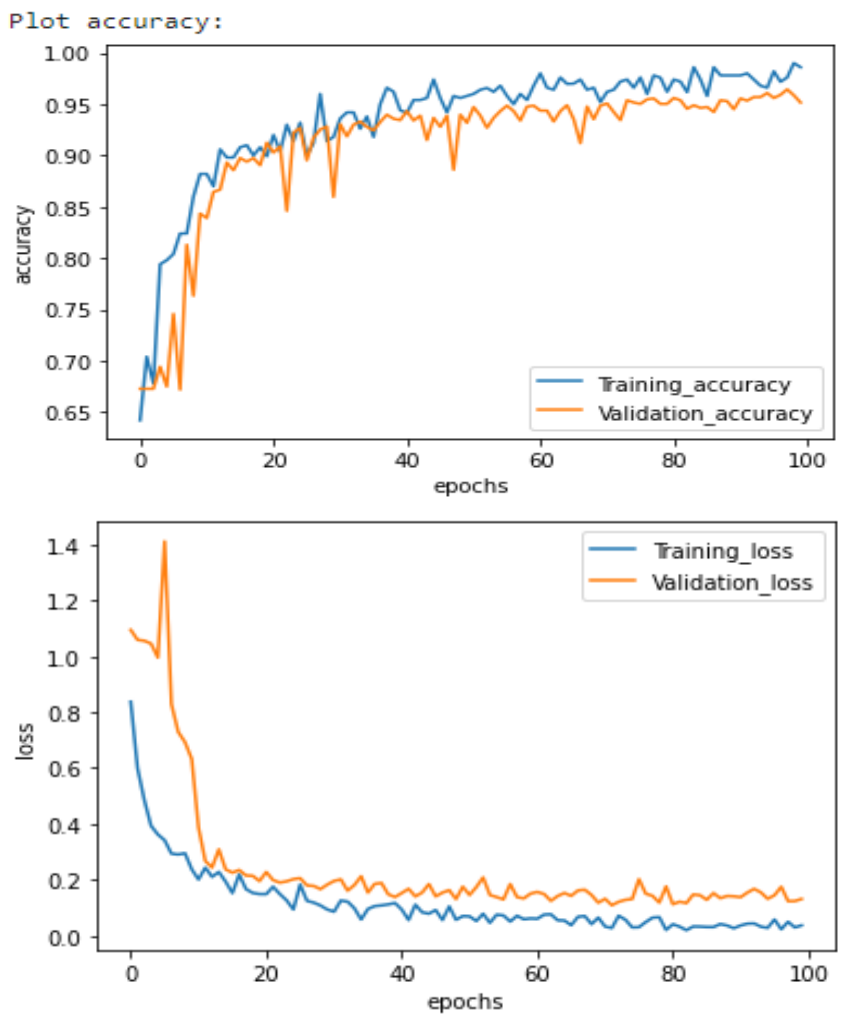
Figure 9. Accuracy and loss performance of the MobileNet model.